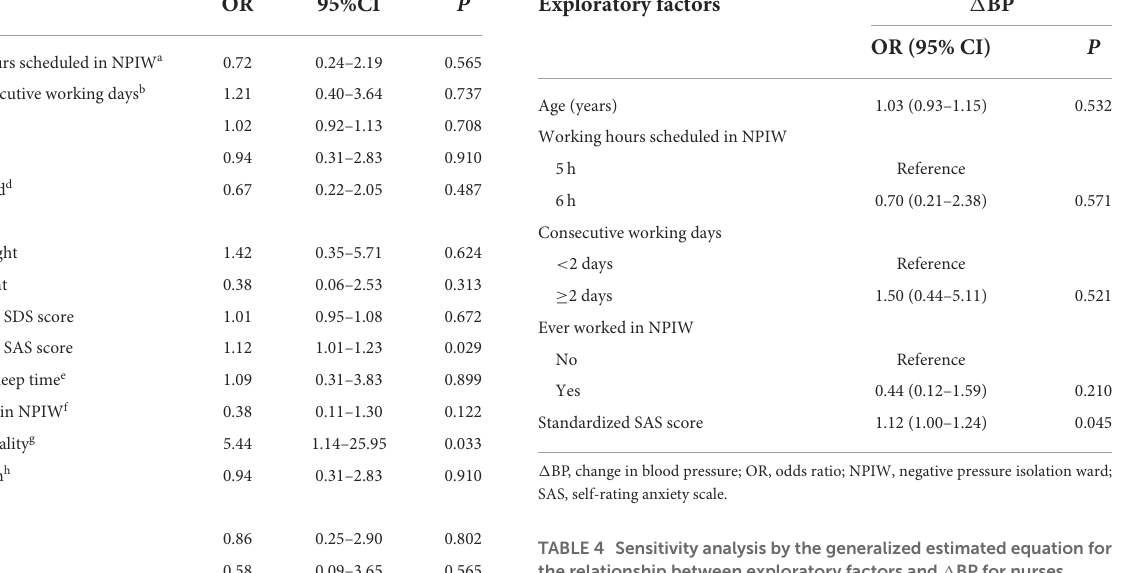
TABLE 3 Multivariable analysis for the relationship between exploratory factors and 1 BP for nurses working in NPIW. Exploratory factors